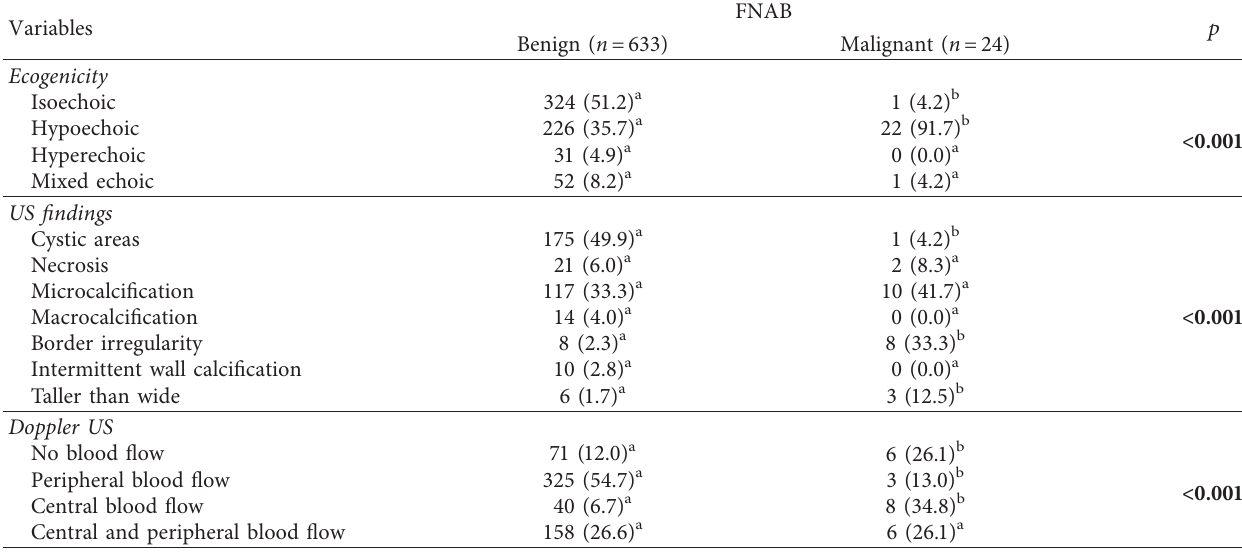
Table 3: Evaluation of FNAB results according to ultrasonographic features.